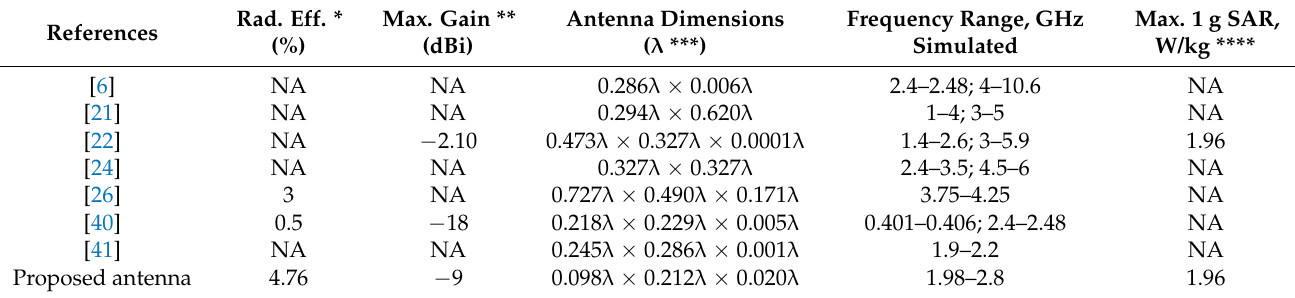
Table 2. Comparison of the metrics of the different body-worn antennas with the proposed